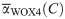
Effect of hormones on CARENET activity.A, α¯WOX4(C) obtained in the simulations experiments where corresponding hormone (control node) is turned on (dark green bars) or off (pale green bars). B, α¯WOX4(C) obtained in the simulations experiments where TDIF was always on (TDIF = 1) and corresponding hormone is turned on (dark green bars) or off (pale green bars). N/A, not applicable. C, Effect of gibberellins and brassinosteroids on α¯WOX4(C) under conditions when the rest of the control nodes were on.